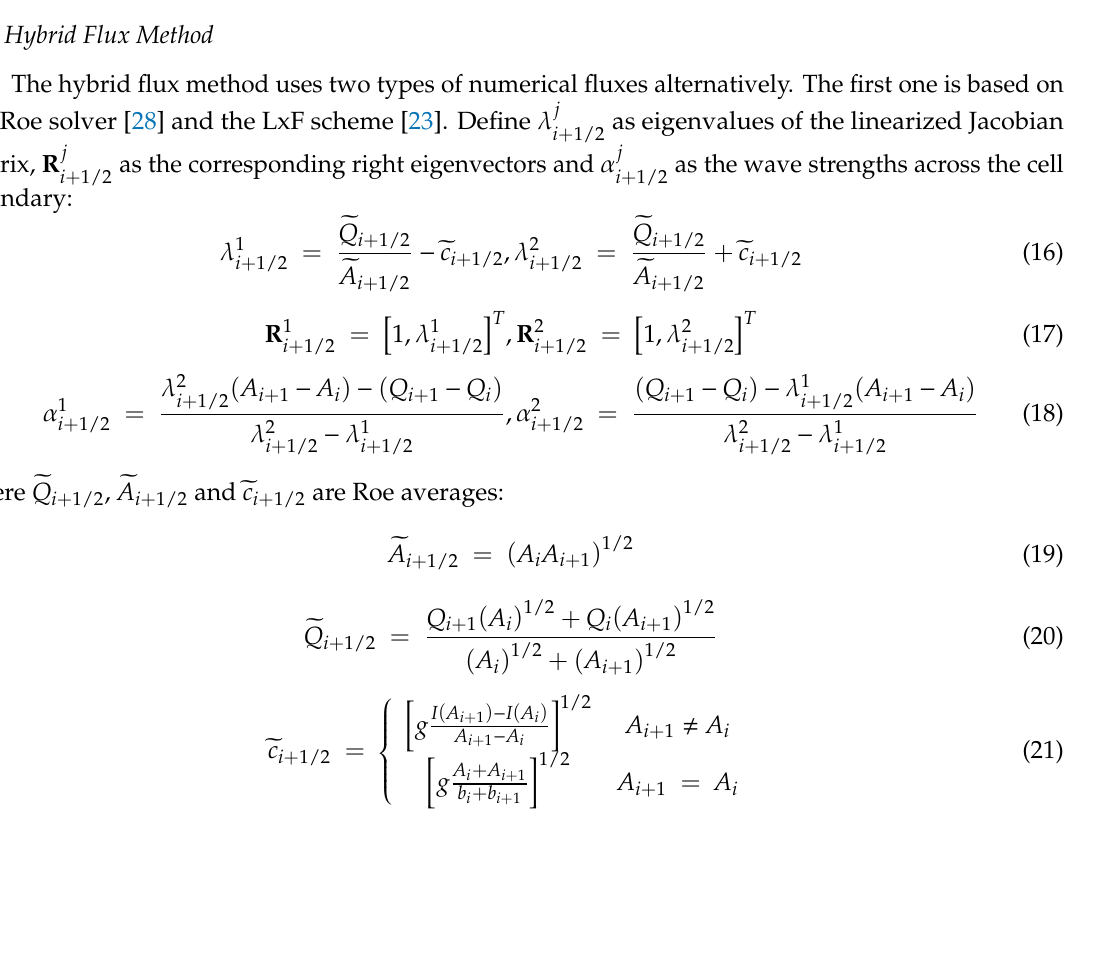
Figure 3. Comparison of results simulated by the numerical filtering method (filtered) and the analytical result (AR): ( a ) piezometric head; ( b ) flow velocity.